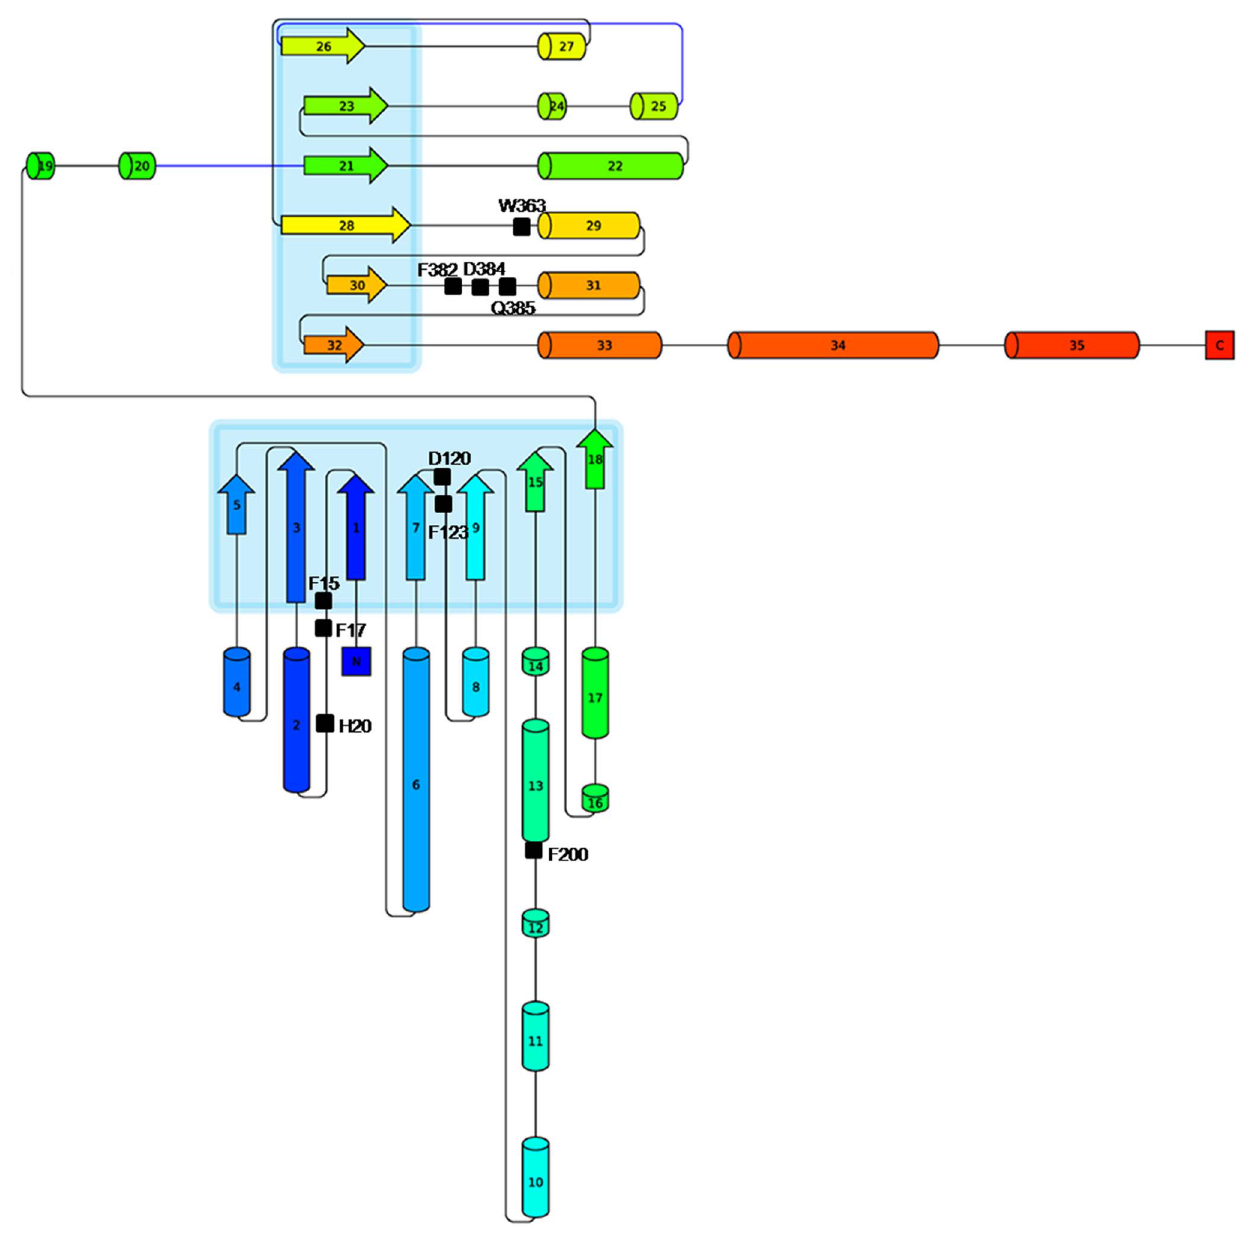
Figure 2. Topology diagram of UGT. Topology diagram of UGT from F. ananassa shows CTD and NTD having an architecture of Rossmann fold. An arrangement of alternate b / a / b secondary structure elements can be seen in the diagram along with the key catalytic and binding site residues of acceptor and sugar donor shown by square mark and labeled.